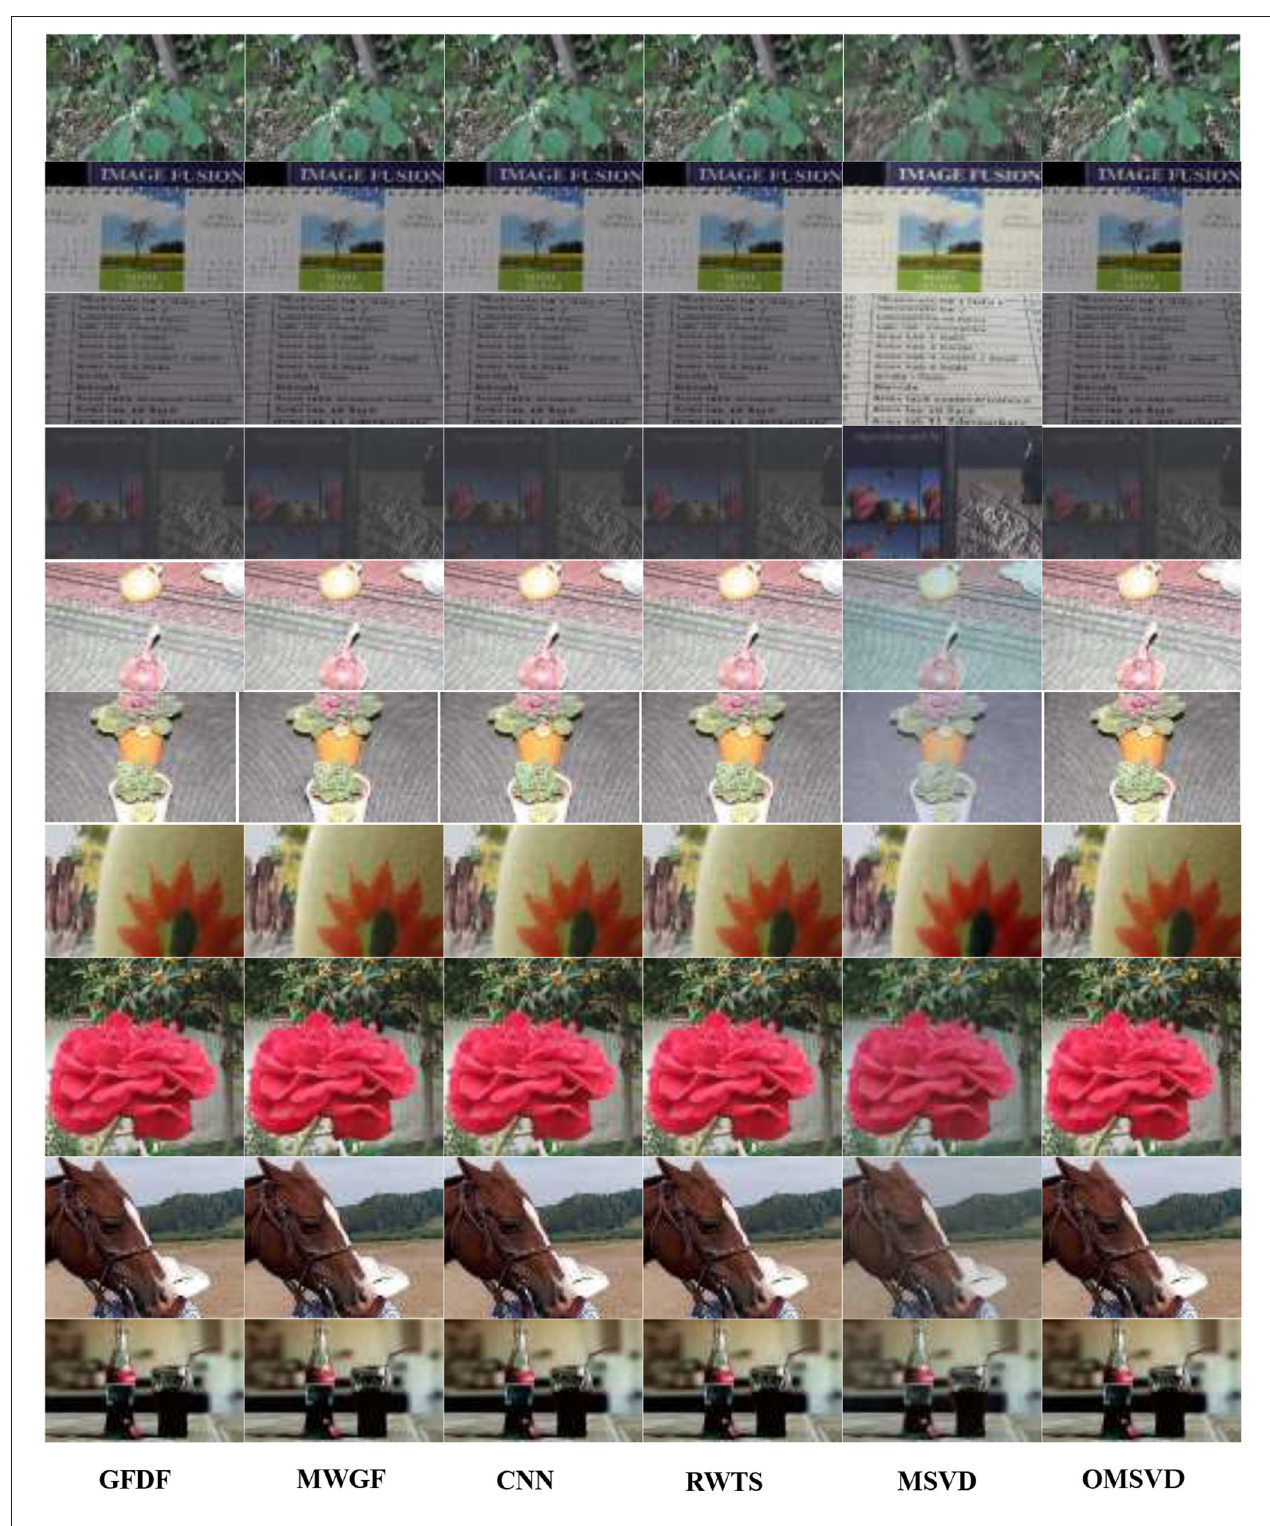
FIGURE 7 | Ten groups of multi-focus color fusion images.